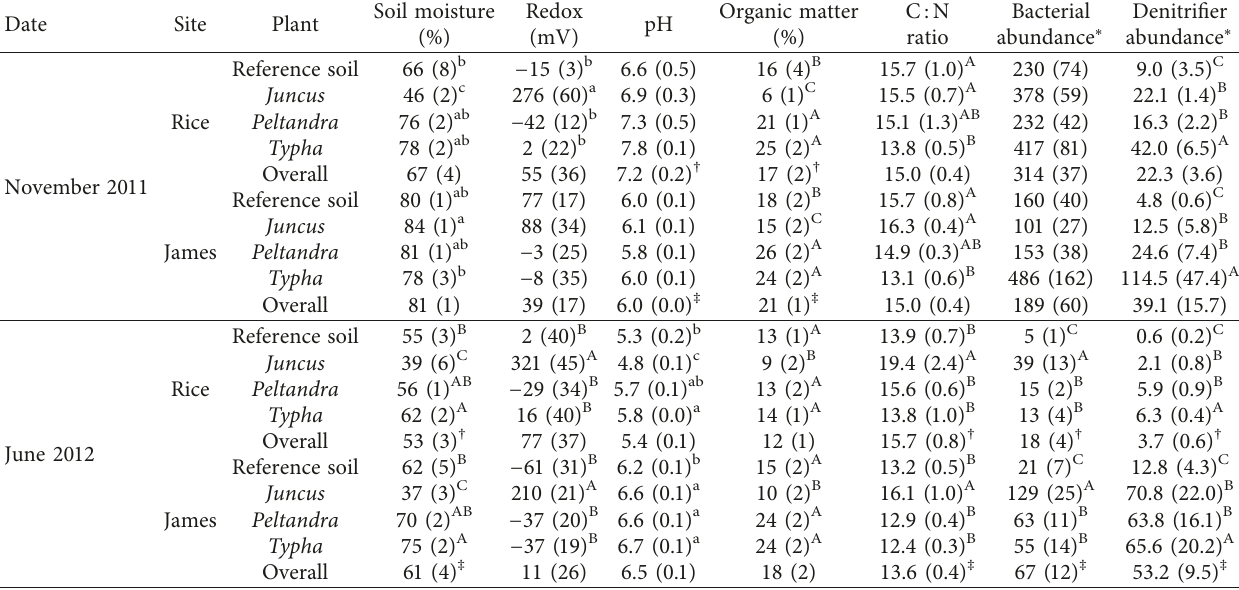
Table 1: Soil physicochemical properties and microbial abundance data reported as means and standard errors.